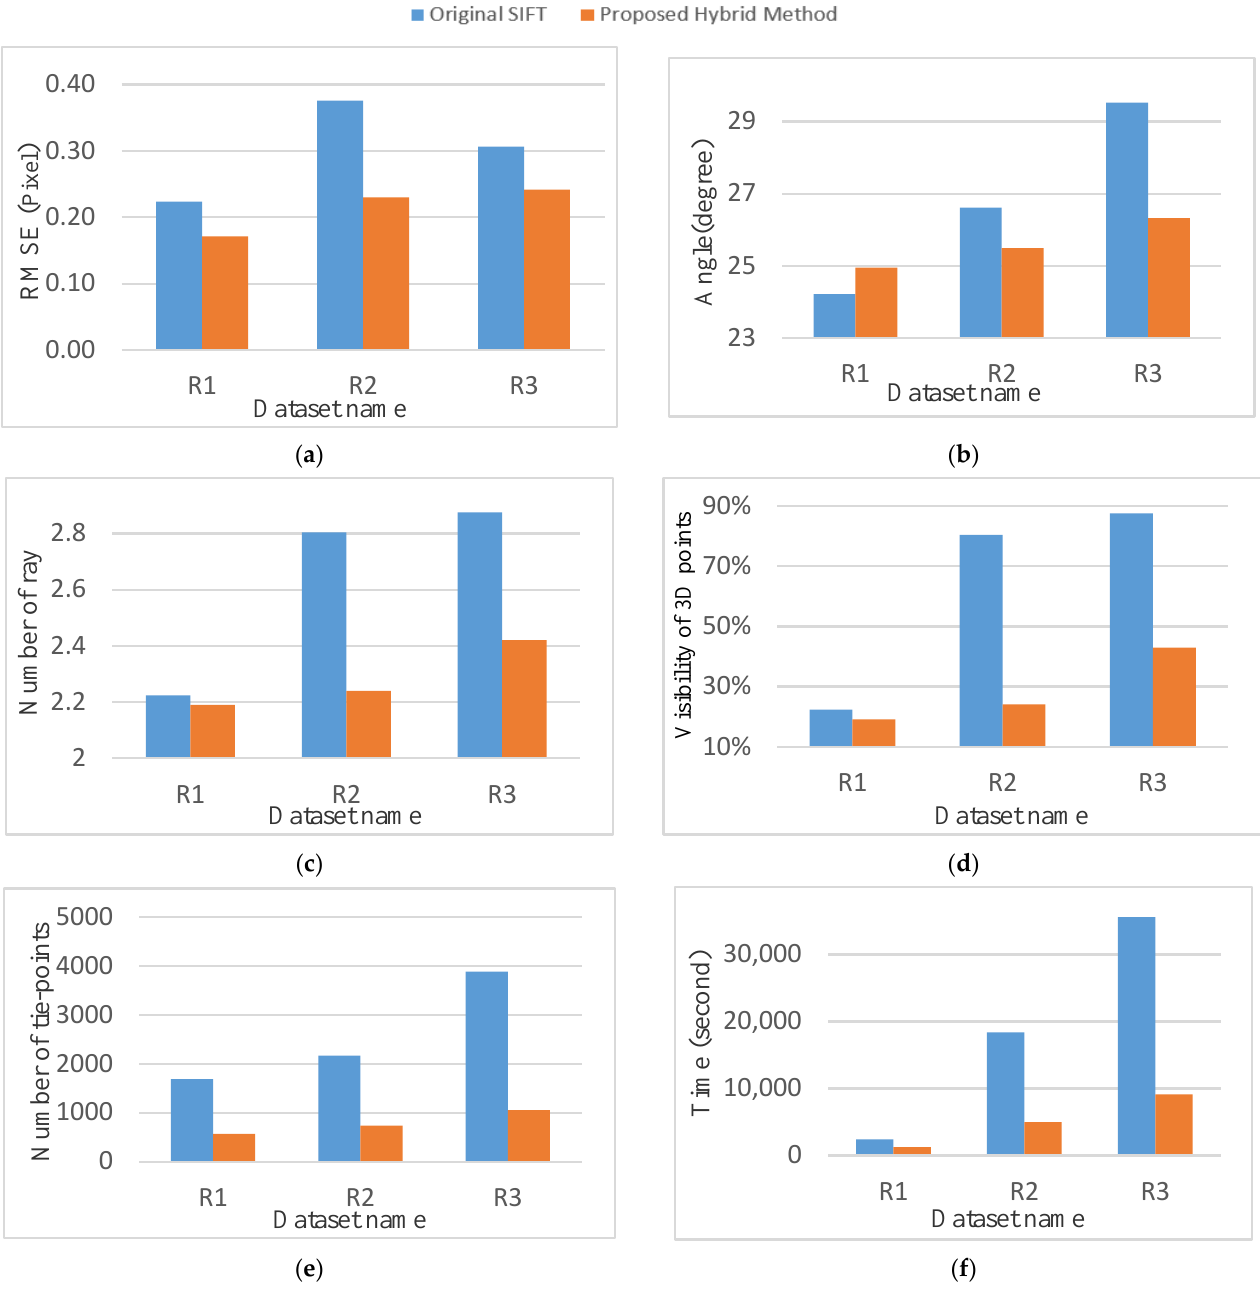
Figure 12. Comparison results of the proposed method. ( a ) Re-projection error of the bundle adjustment, ( b )average intersection angles, ( c )average rays per computed 3D points, ( d )the visibility of the derived 3D points in more than 3 images, ( e )the number of 3D-points, ( f )processing time.